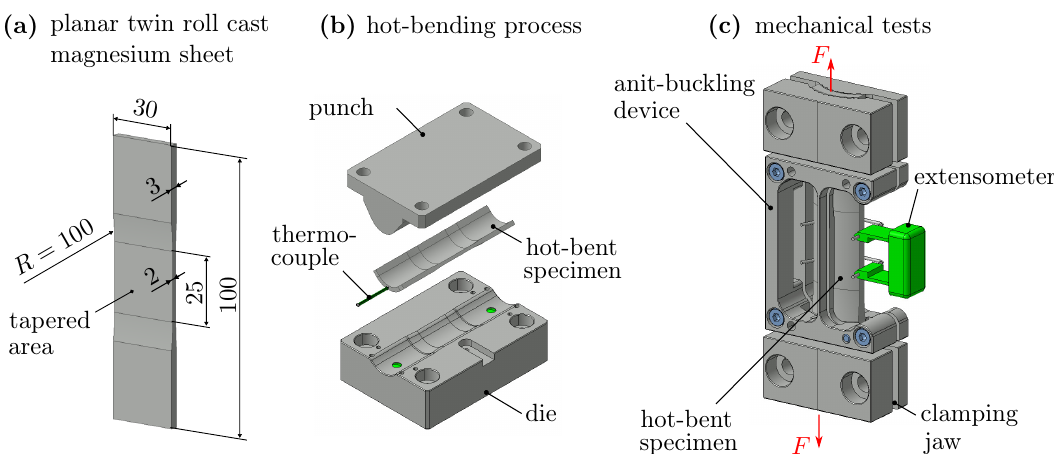
Figure 1. Manufacturing process of the hot-bent uniaxial specimen: ( a ) taper of the planar twin-roll cast magnesium sheets; ( b ) hot-bent process; ( c ) assembly for mechanical testing with the clamping jaws, the anti-buckling device, the extensometer, and the hot-bent uniaxial specimen.